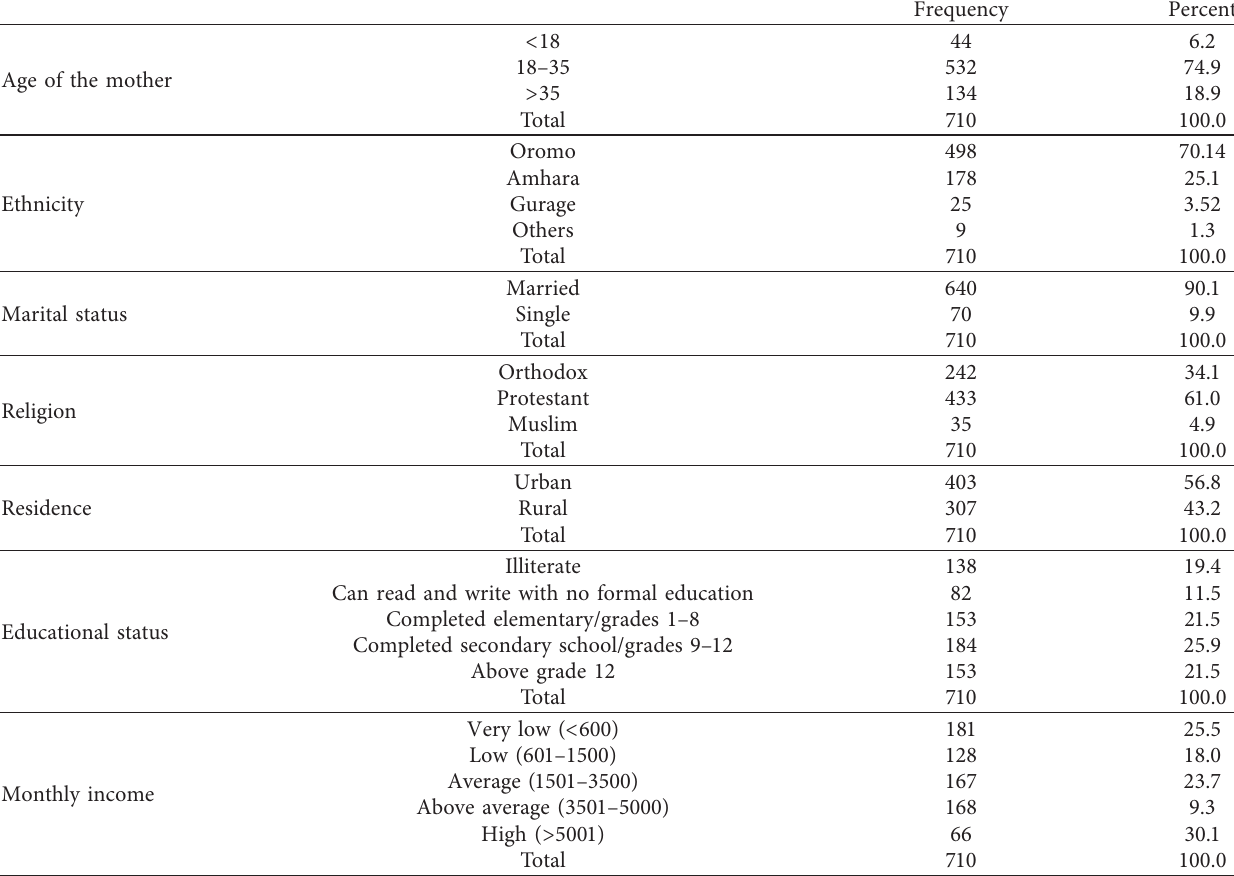
Table 1: Sociodemographic characteristics of the study participants among women in west Shoa zone.